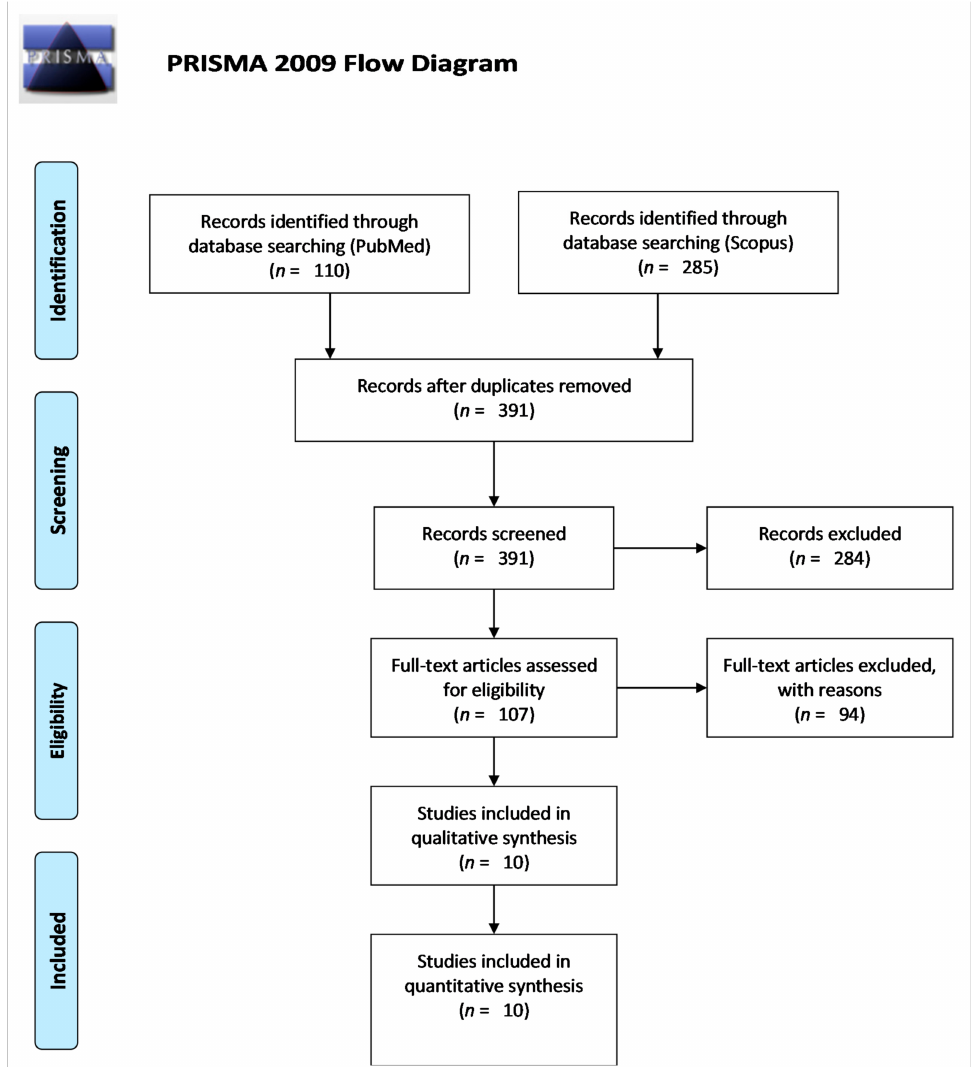
Figure 1. PRISMA 2009 Flow Diagram. From Moher, D.; Liberati, A.; Tetzlaff, J.; Altman, D.G. The Prisma Group (2009). Preferred reporting items for systematic reviews and meta-analyses: The PRISMA statement. PLoS Med 6(7): e1000097. https://doi.org/10.1371/journal.pmed.1000097. For more information, visit www.prisma-statement.org